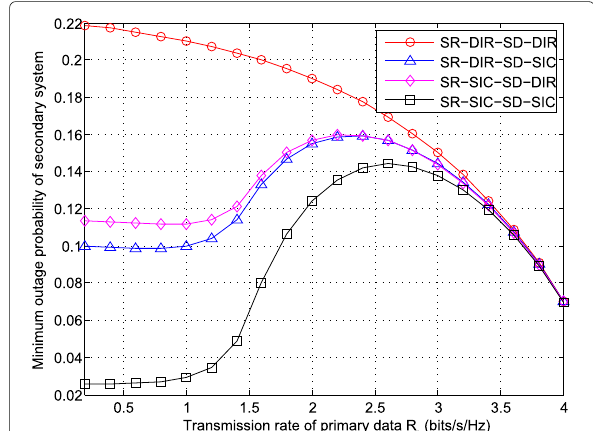
Fig. 16 Minimum outage probability of secondary system vs the transmission rate R